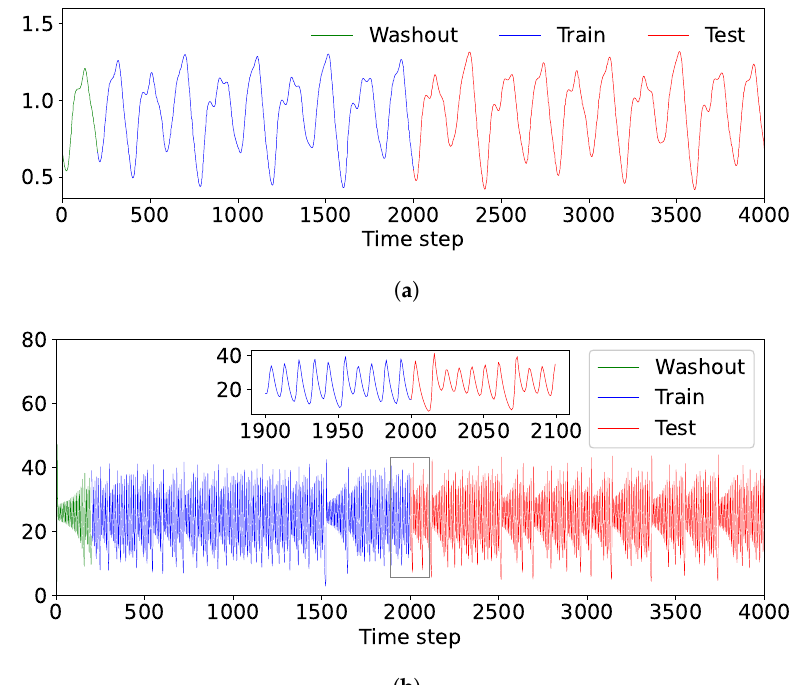
Figure 6. MG ( a ) and LZ ( b )